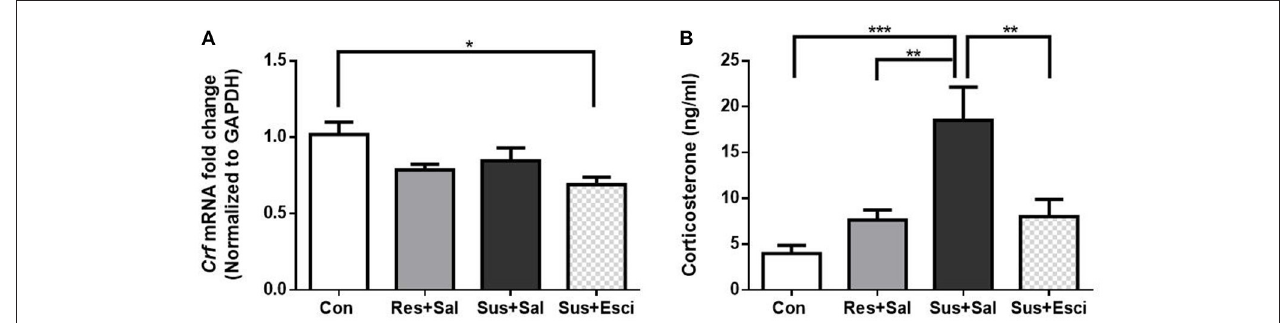
FIGURE 5 | Crf mRNA expression in hypothalamus and serum CORT after 4 weeks treatment. (A) mRNA expression of Crf in the hypothalamus of mice after 4 weeks treatment [ n (Con) = 6; n (Res + Sal) = 5; n (Sus + Sal) = 6; n (Sus + Esci) = 6]. (B) Serum CORT concentration of mice after 4 weeks treatment [ n (Con) = 7; n (Res + Sal) = 5; n (Sus + Sal) = 4; n (Sus + Esci) = 6]. All data are shown as mean ± s.e.m. * P < 0.05, ** P < 0.01, *** P < 0.001. Con, Control; Res + Sal, Resilient + Saline; Sus + Sal, Susceptible + Saline; Sus + Esci, Susceptible +